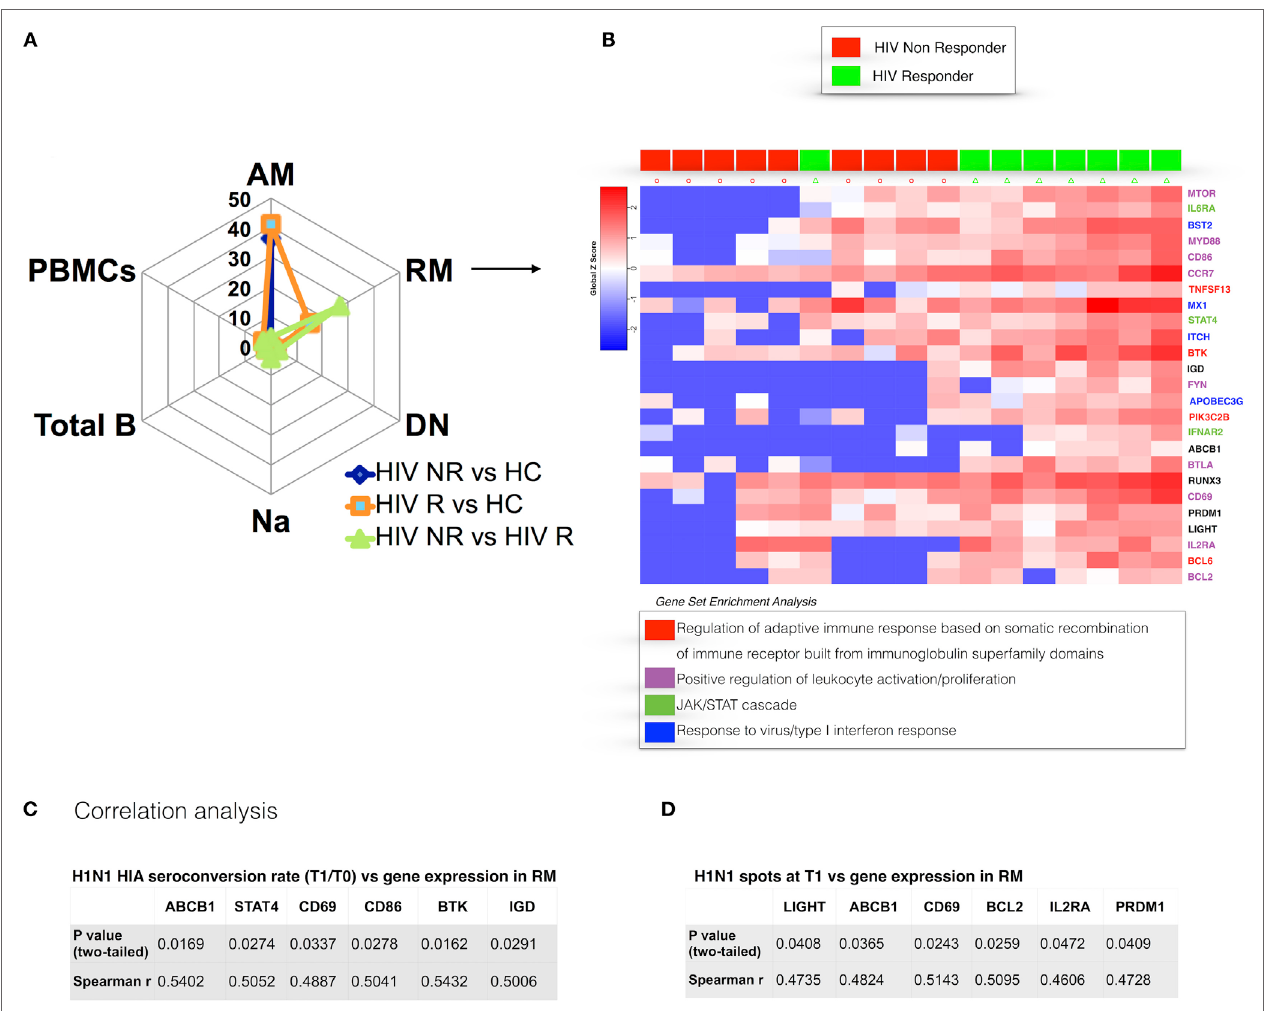
FigUre 4 | Prevaccination gene signatures in RM B cell subset discriminate HIV-infected R and non-responder (NR). (a) Spider plot shows number of differentially expressed genes (DEGs) for all the subsets and total peripheral blood mononuclear cells (PBMCs). (B) Heatmap shows gene expression in R and NR. Colored genes’ names refer to gene set enrichment analysis (GSEA) legend. In panels (c,D) , correlation between gene expression in resting memory and H1N1- seroconversion (c) and ELISpot at T1 (D) are shown. p and r values show results from correlation analyses (Pearson or Spearman tests for parametric and non-parametric data,